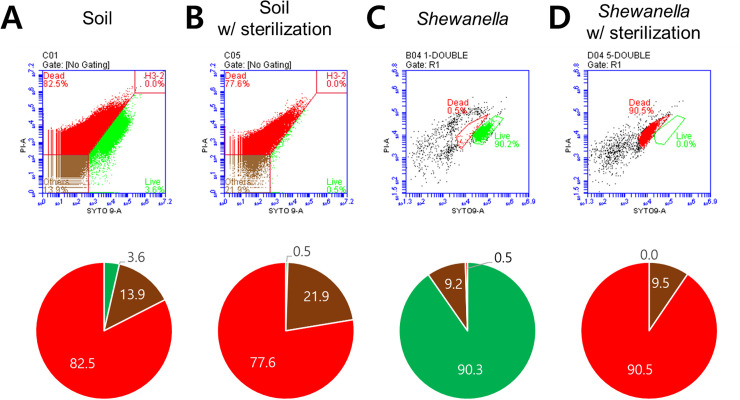
Scattered graphs (A and C) and pie charts (B and D) of bacterial numbers determined by FCM. The results of A and B indicate the bacterial numbers in the farmland soil sample (A1 at 10–20 cm), and those of C and D show the bacterial numbers in the single cell cultured media (Shewanella sp. in R2A media). Live cells, dead cells, and soil mineral and organic matter particles are shown in green, red, and brown, respectively. The samples were stored at 4°C and pretreated by vortexation at maximum speed for 5 min, sonication at 300 W for 3 min, centrifugation at 1400 × g for 15 min, and filtration through 10 μm filters.